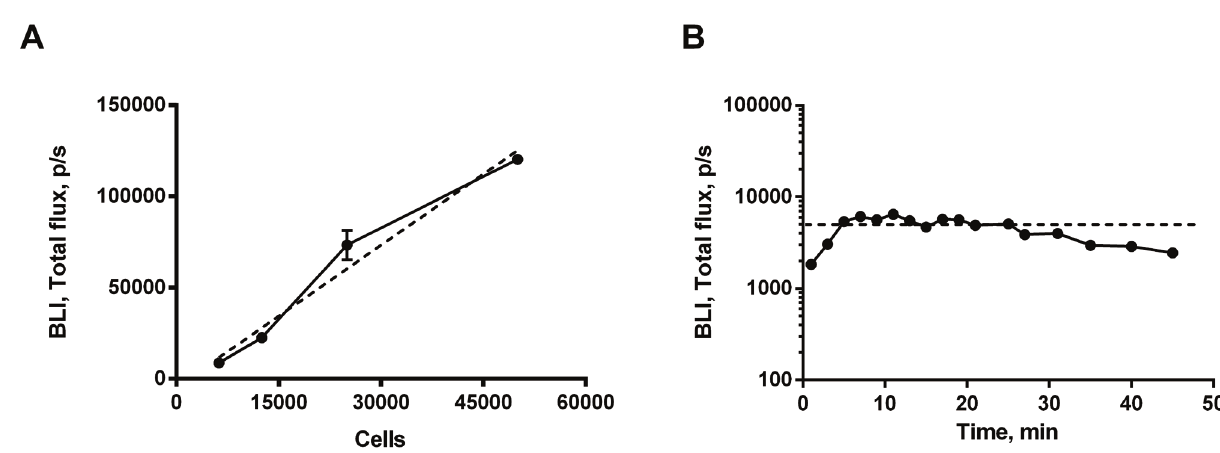
Figure 1. ( A ) In vitro quantification of bioluminescence signal. Linear regression demonstrated that the signal increased linearly with the number of cells (dotted line), p<0.0001. ( B ) In vivo quantification. The bioluminescence signal increased during the initial 5min following i.p. injection. After 5min the signal reached a stable plateau lasting for approximately 20min. Results from two